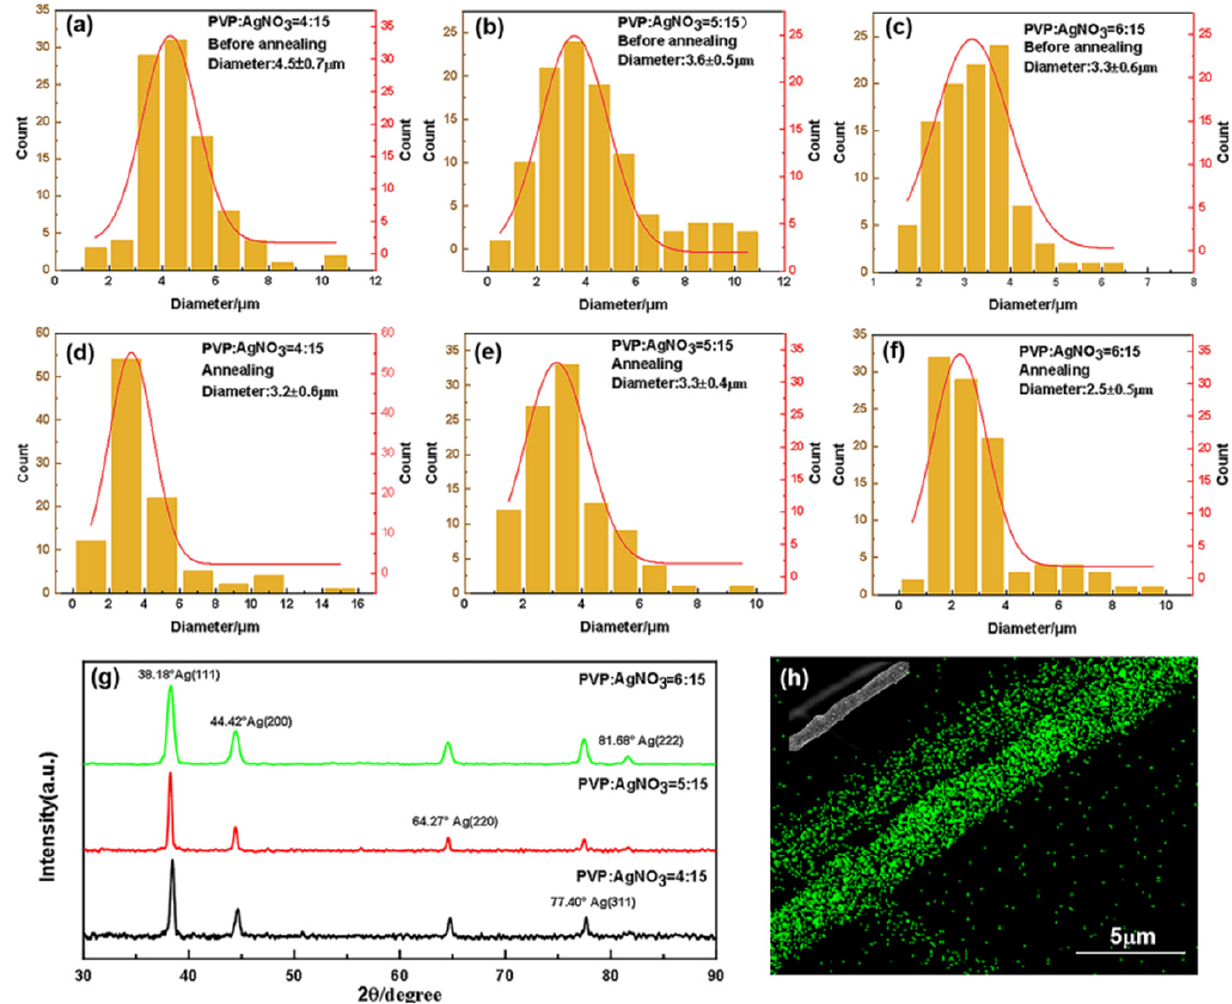
Figure 3. Diameter analysis and physical characterization of centrifugally spun microfibers made with different PVP/AgNO 3 weight ratios. Diameter of centrifugal spun silver precursor fibers at a weight ratio of PVP:AgNO 3 at 4:15 ( a ), 5:15 ( b ), and 6:15 ( c ). Diameter of annealed silver fibers at a weight ratio of PVP:AgNO 3 at 4:15 ( d ), 5:15 ( e ), and 6:15 ( f ). ( g ) The XRD patterns of annealed silver fibers were prepared from different PVP/AgNO 3 weight ratios. ( h ) The EDS image of annealed fibers shows the Ag element distributed on the fiber.